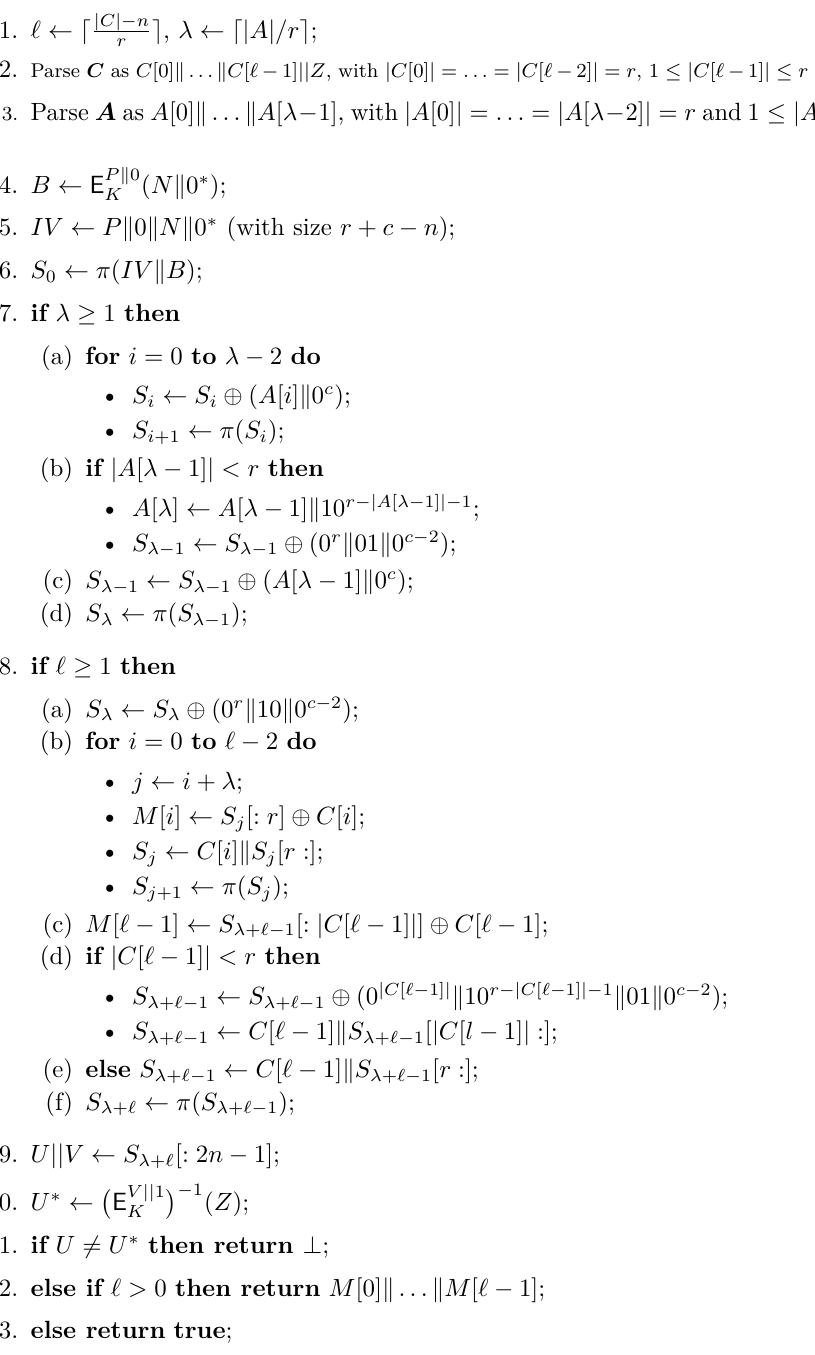
Algorithm 4 TETSponge [ E , π ] . Dec ( A , C , N, K || P